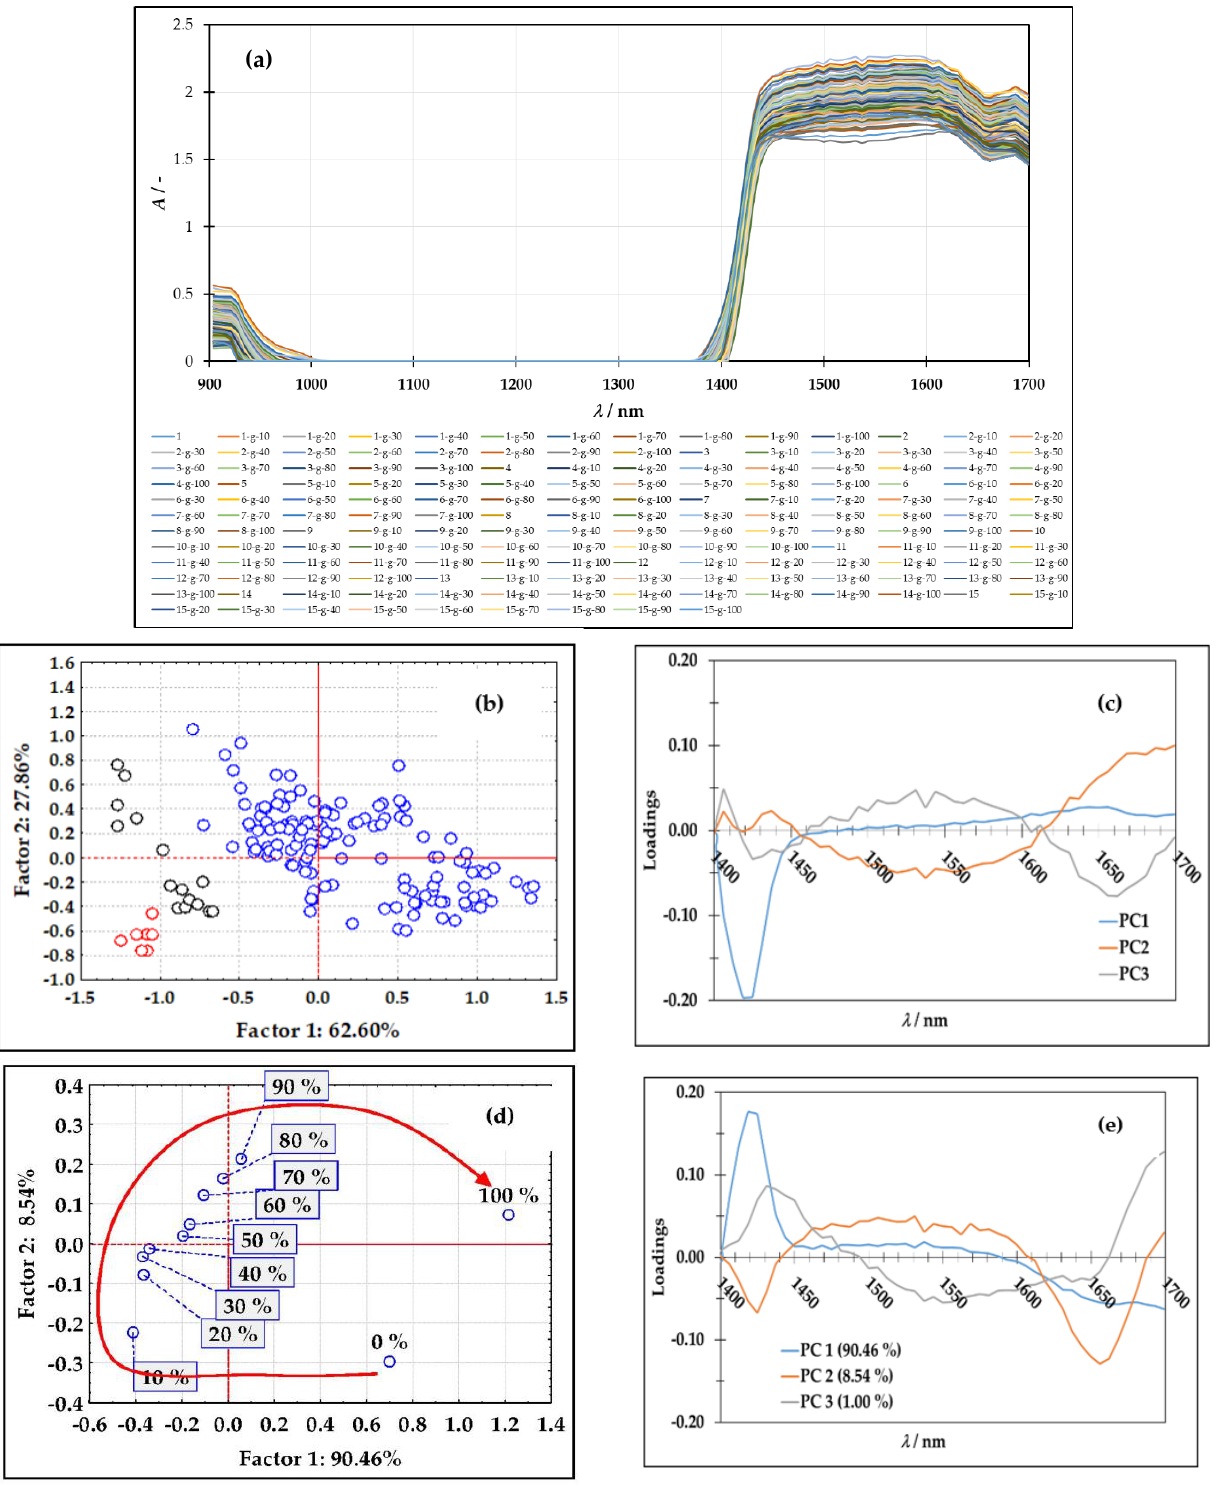
Figure 2. ( a ) NIR spectra of pure honey samples and prepared glucose syrup adulterations (N = 160); ( b ) PCA score plot of NIR spectra after MSC pre-processing (o—0% of adulterant; o—10–90% of adulterant; o—100% of adulterant); ( c ) PCA loading plot after NIR spectra MSC pre-processing; ( d ) PCA score plot of average NIR spectra by adulterant amount after MSC pre-processing; ( e ) PCA loadings of average NIR spectra after MSC